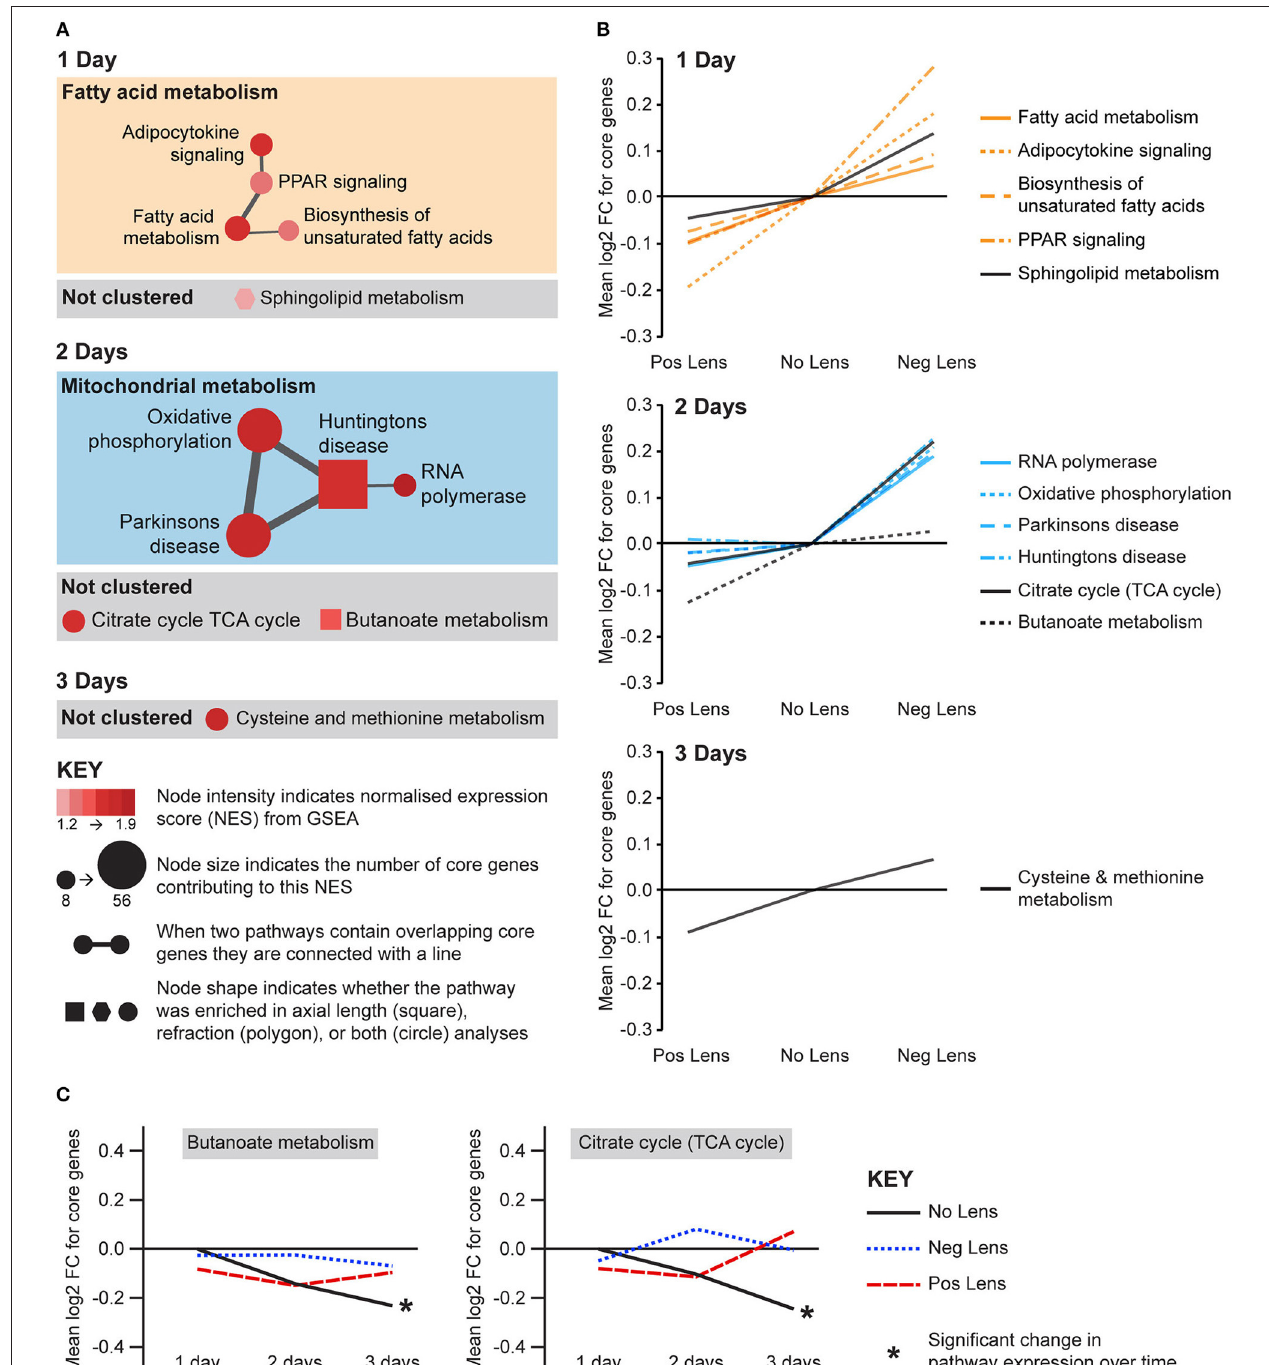
FIGURE 6 | Metabolic pathway expression changes during refractive compensation, and normal development. (A) Network diagrams showing metabolic pathways positively correlated with eye size on days 1, 2, and 3. Each node represents a pathway, and nodes are connected with a line when two pathways contain common core genes (representing related biological processes; thicker lines = more similarity). Node color indicates the direction of expression change (red = positive correlation with axial length and/or negative correlation with refraction). Node intensity indicates the normalized expression score (NES) from the axial length analysis (circle and square nodes) or the refraction analysis (polygon nodes). (B) Line graph showing mean log2-fold change for the core genes responsible for each pathways’ enrichment. Note that this graph indicates that enrichment results on day 2 were primarily driven by changes in one of the two lens groups. (C) Metabolic pathways from “A” also showing expression changes across time within lens groups. Line graphs show the mean log2-fold change for core genes relative to the 1 day no lens group. Note that because the core genes responsible for pathway enrichment vary for within and across group analyses, these values differ from those shown in “B.” For full details of GSEA results see Supplementary Tables S10,